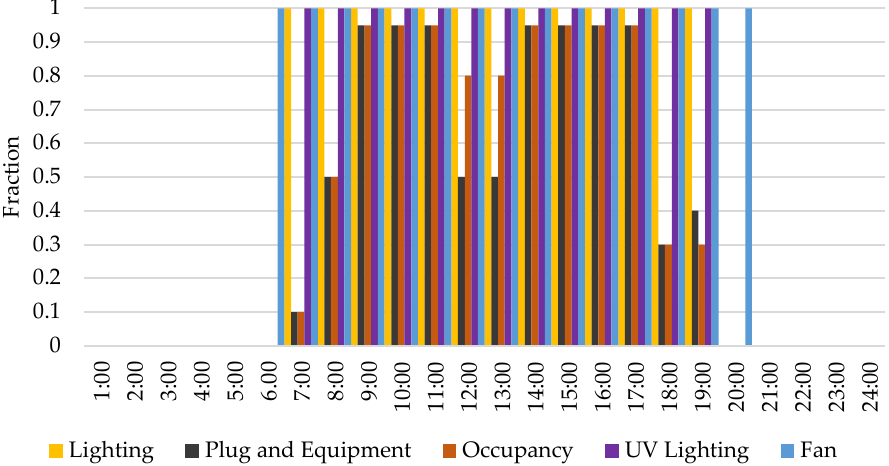
Lighting Plug and Equipment Scheme A2. Building model schedules all year on weekdays in post-C19 scenarios. Designed by the research team. Table A1. Fans EUI per location in pre- and post-C19 scenarios.